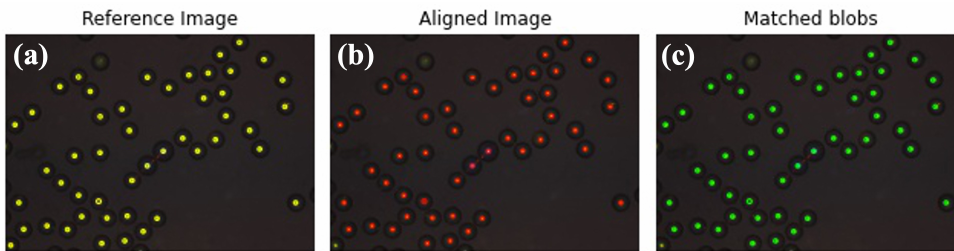
Figure 7. Detected blobs’ in a CSR response: ( a ) reference image, ( b ) aligned image, ( c ) matched blobs between the reference and the aligned